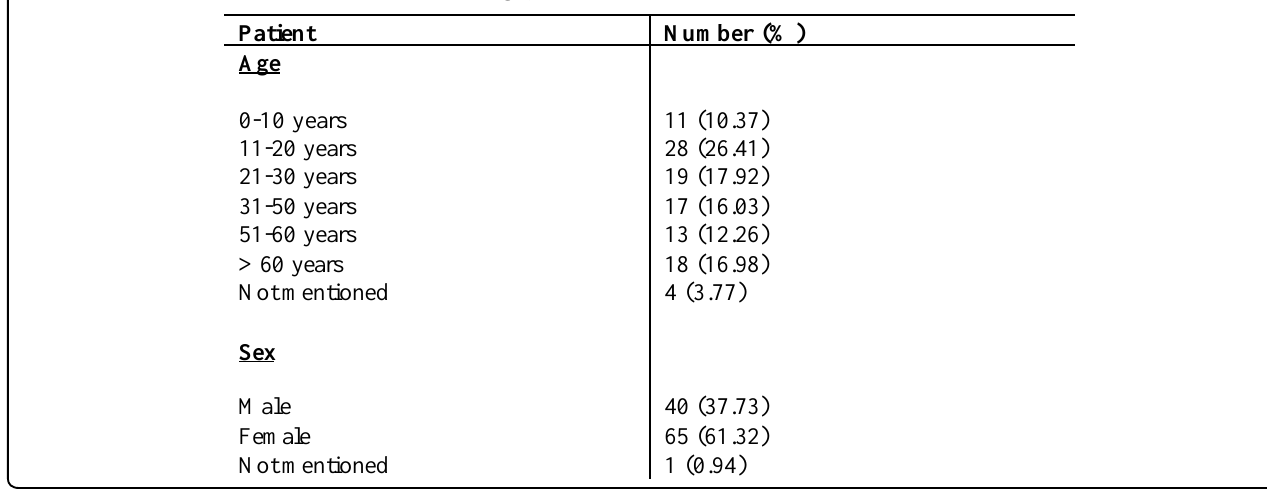
Table I : Age, Sex distribution of Patient (n =